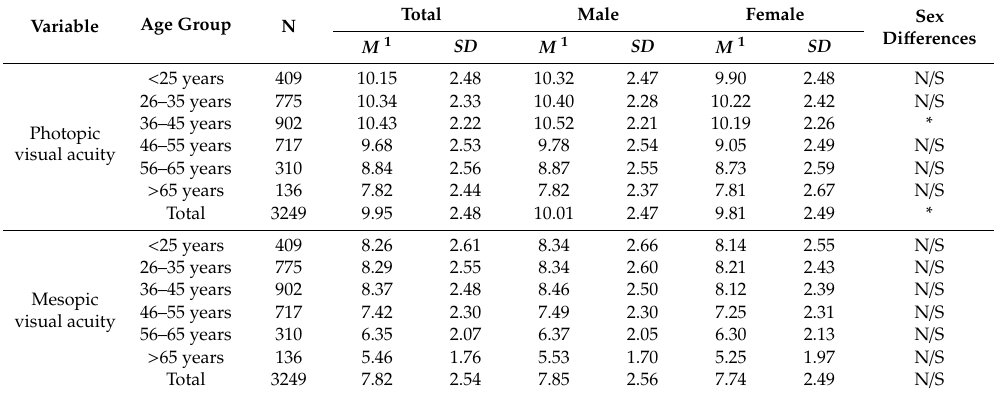
Table 2. Results from visual acuity tests (photopic and mesopic) by age group, sex and overall sample. Variable Age